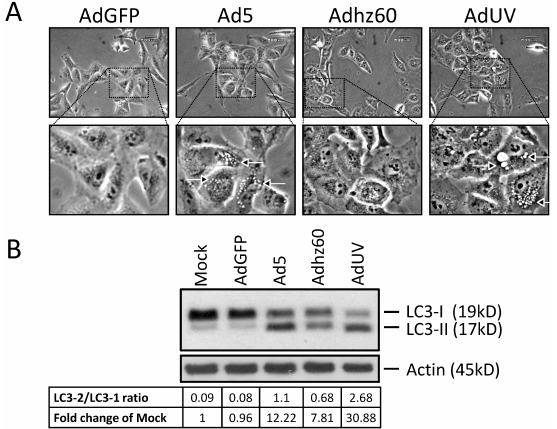
Figure 5. AdUV induces greater autophagy in A549 lung cancer cells. ( A ) Pictures of A549 cells (400× total magnifications) treated with the indicated Ads at an MOI of 1 for three days. Boxes indicate the magnified (~9.3× total magnifications) to emphasize the presence or absence of vesicle formation in the cytoplasm. White bordered arrows were used to indicate these vesicles; ( B ) A549 cells were treated with the indicated Ads at an MOI of 1 for five days and observed for LC3 expression by Western blot analysis. Densitometric analysis of LC3-II to LC3-I and actin were performed using Gel-pro analyzer 4.0 software. LC3 expression was normalized to actin